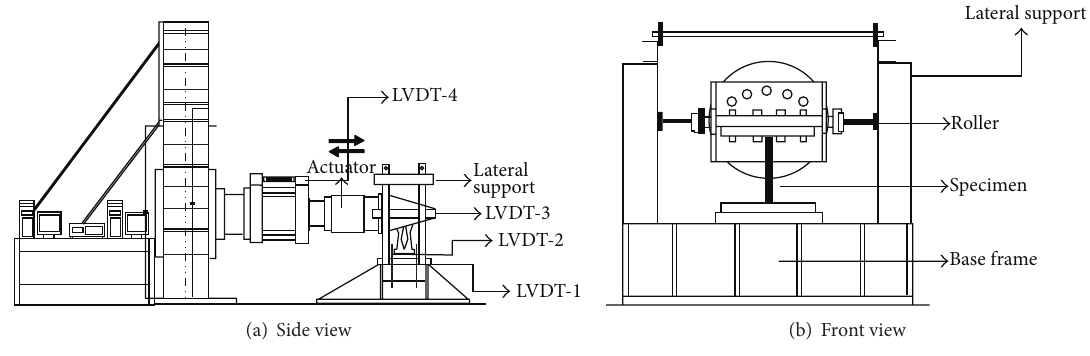
Figure 6: Test equipment.